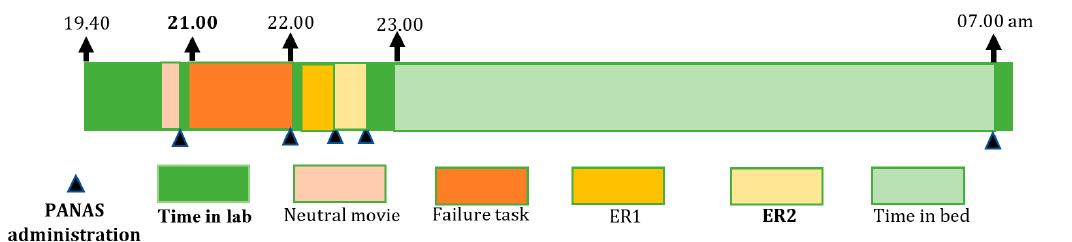
Figure 1. The timeline set ‐ up for the experimental failure night. Abbreviations: PANAS = Positive and Negative Affect Schedule; ER1 = the first time of emotion regulation; ER2 = the second time of emotion regulation.